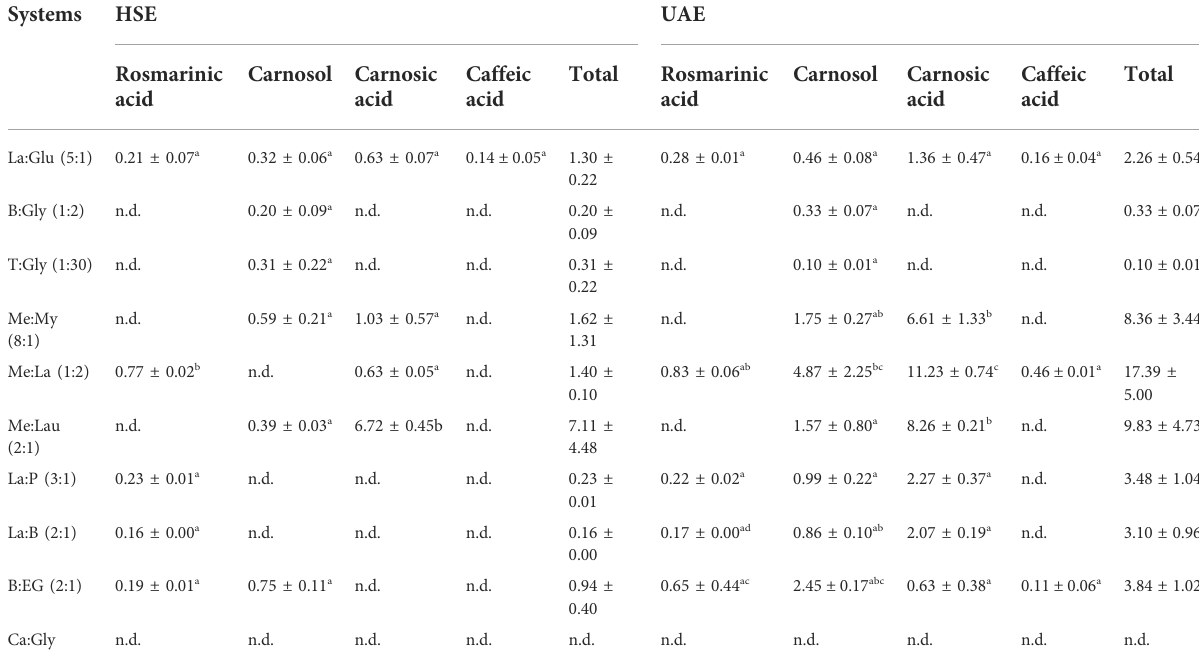
TABLE 4 Extraction amount of rosmarinic acid, carnosol, carnosic acid, and caffeic acid (mg/g rosemary), extracted with different NADESs under the same extraction conditions,S:L ratio of 1:20,40 ° C,and 60 min,usingtwo different techniques HSEand UAE. Resultsare expressed as mean ±SD. Statistically signi fi cant differences between the effect of the HSE and UAE using NADESs arerepresent by letters. Differentletters indicatesigni fi cant differences within each extraction technique.